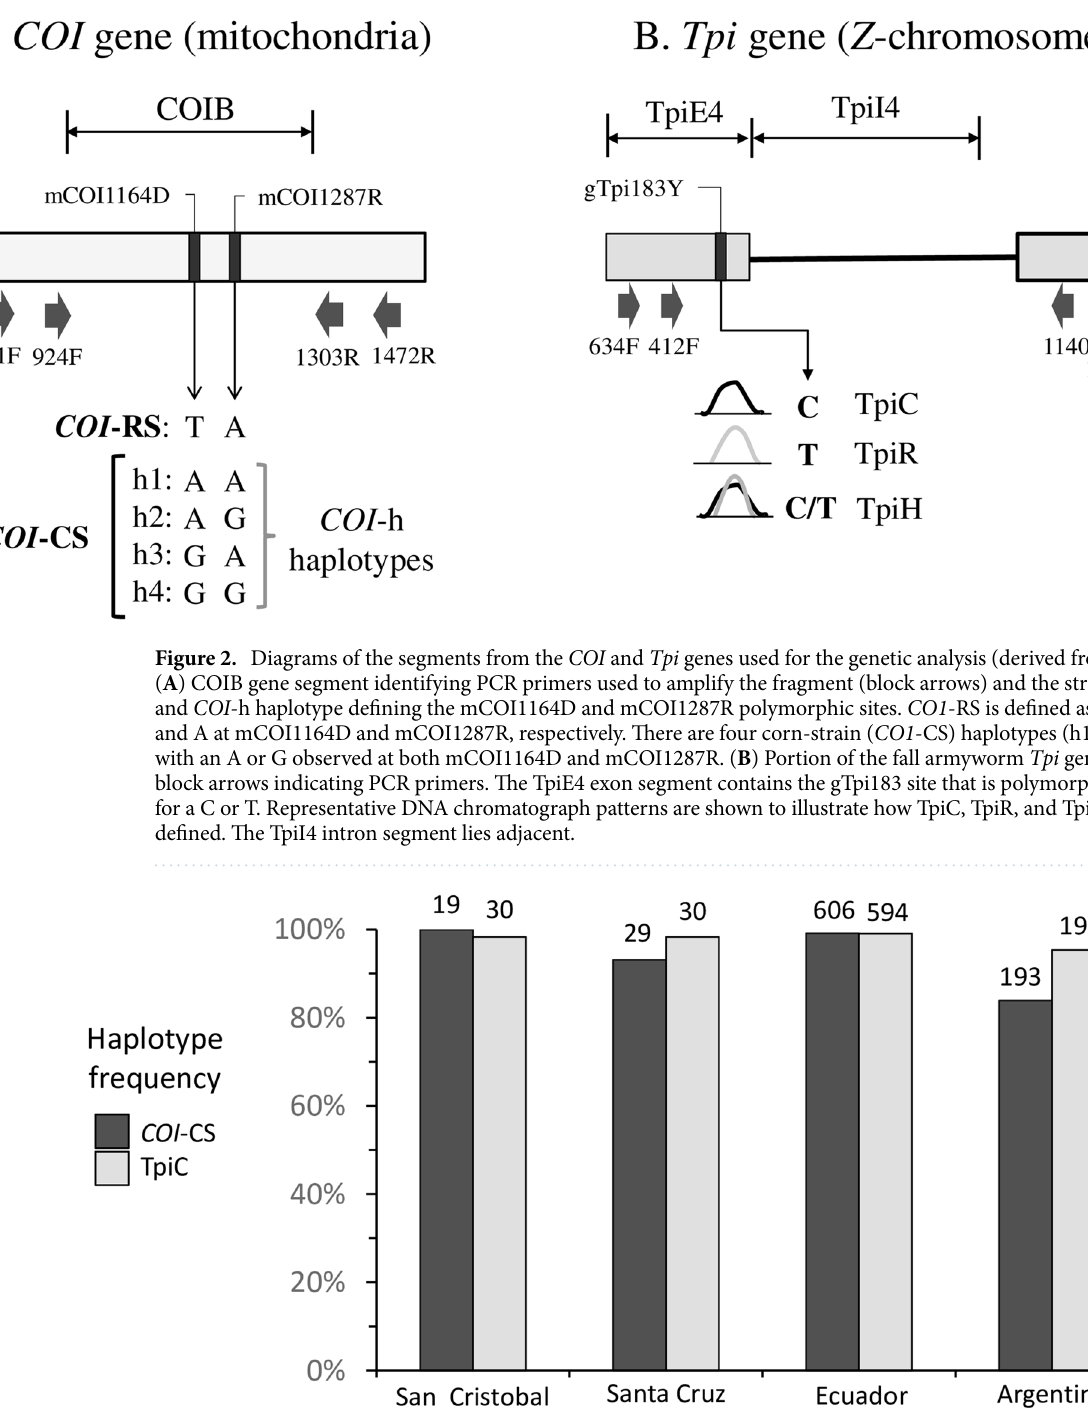
Genetic variation as measured by haplotype diversity was similar in all Ecuador locations, ranging between